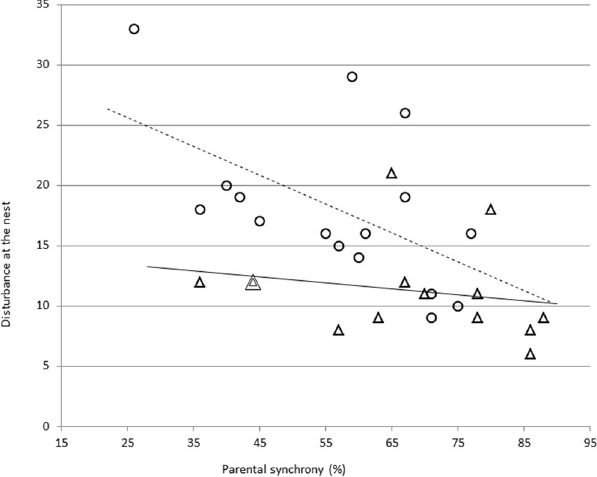
Figure 2. Relationship between the synchrony of parental feeding flights and the disturbance at the nest during the poikilothermic nestling stage ( ∆ , n = 14 nests) and the endothermic nestling stage ( ○ , n = 16 nests). Overlapping points are indicated by concentric circles and/or triangles (the number of symbols represents the number of overlapping points). The fitted lines serve for visualization purposes, not for statistical inference.